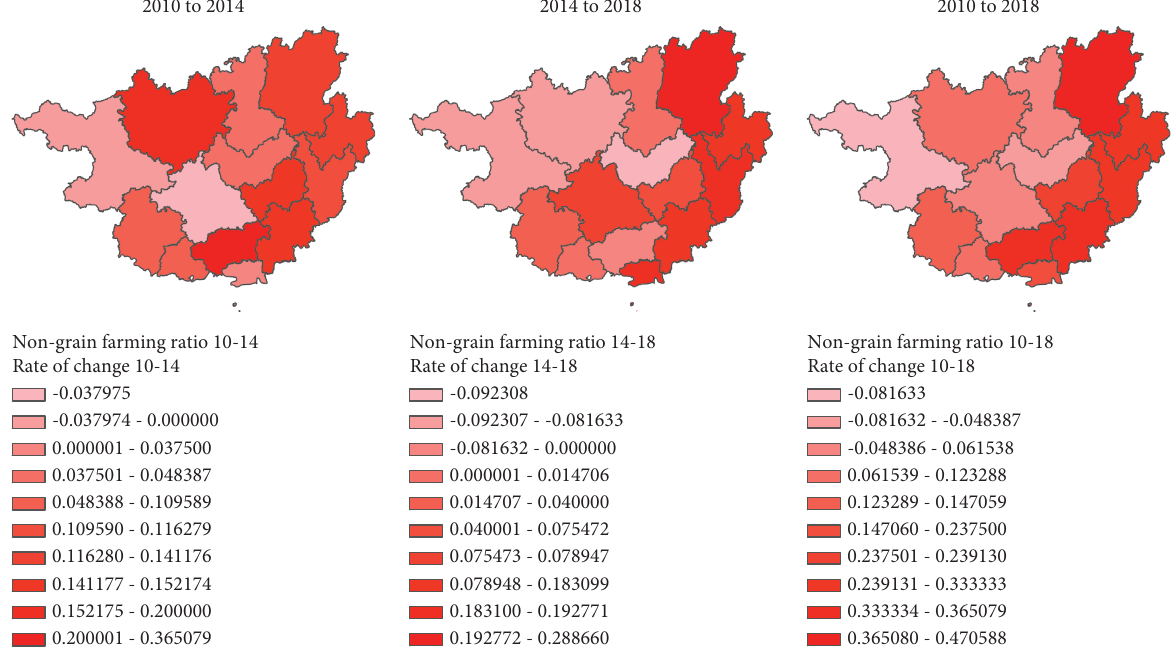
Figure 10: Change rate map of nongrain cultivated ratio in Guangxi from 2010 to 2018.